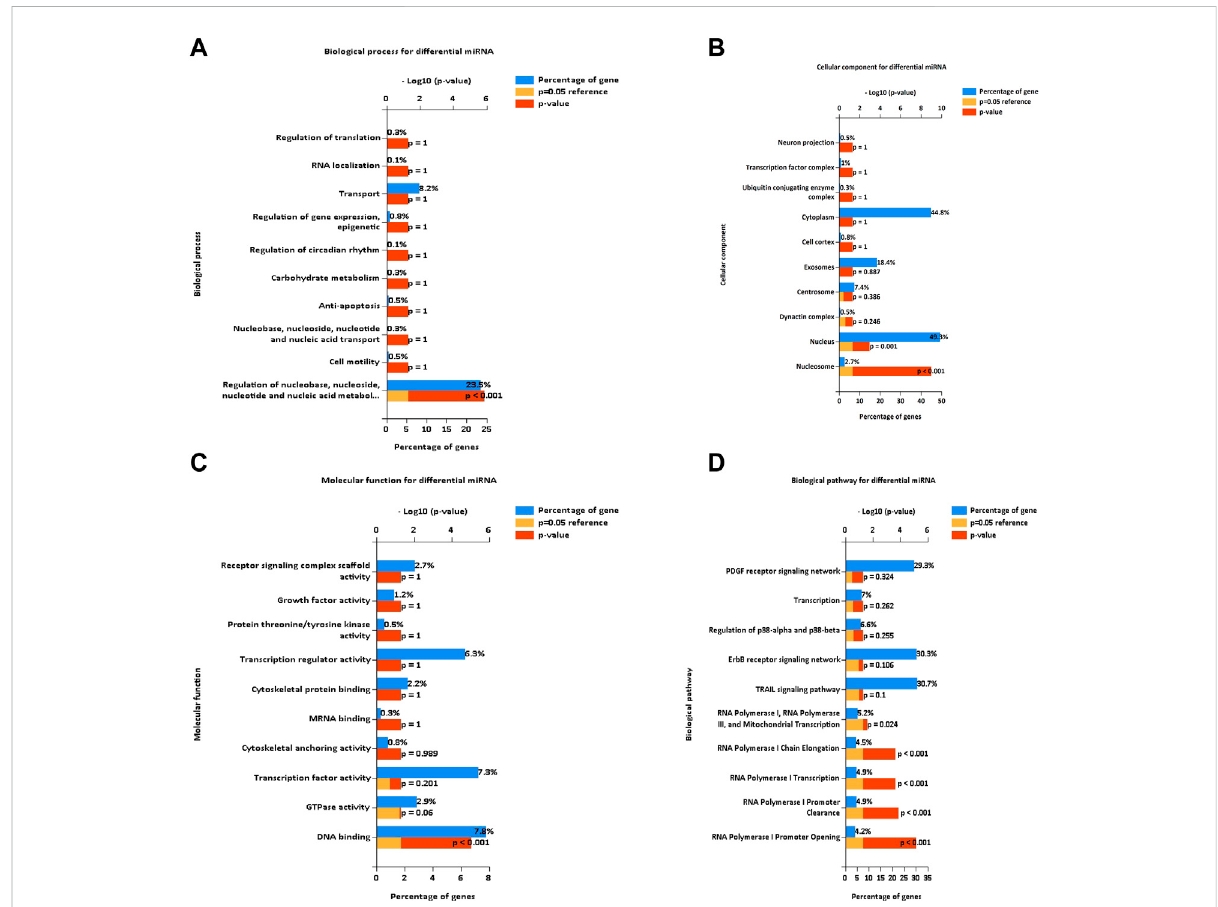
FIGURE 3 Enrichment analysis ofdifferentiallyexpressedmiRNAs.GOand KEGGenrichmentanalysesofDE miRNAs. (A) Bar diagramofBP. (B) Histogram of CC. (C) Histogram of MF. (D) Bar diagram of KEGG. GO, Gene Ontology; BP, biological process; CC, cellular component; MF, molecular function; KEGG, Kyoto Encyclopedia of Genes and